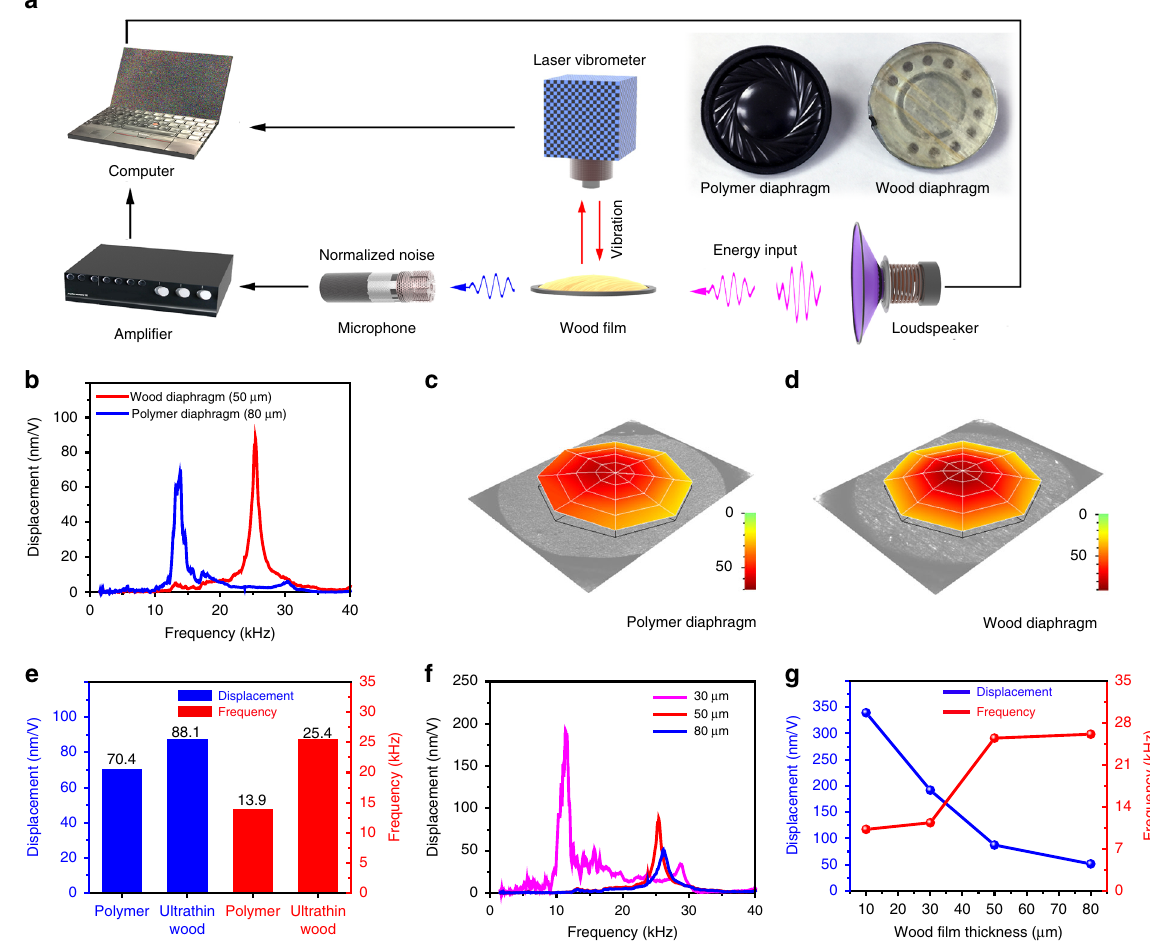
Fig. 4 Acoustic properties of wood fi lms. a Schematic of the vibrational frequency response measurement system. Insets: photographs of the commercial polymer diaphragm and ultrathin wood fi lm. b The vibrational frequency response characteristics of the ultrathin wood fi lm (50 μ m) and the commercial polymer (80 μ m) diaphragms. c , d The (0, 1) mode shapes of the polymer (80 μ m) and ultrathin wood fi lm (50 μ m) diaphragms, respectively. e Comparison of the corresponding displacement and fi rst resonance frequency of the ultrathin wood fi lm (50 μ m) and polymer (80 μ m) diaphragms. f The vibrational frequency response characteristics of the ultrathin wood fi lm at different thicknesses. g The corresponding displacement and fi rst resonance frequency as a function of the thickness for the wood fi